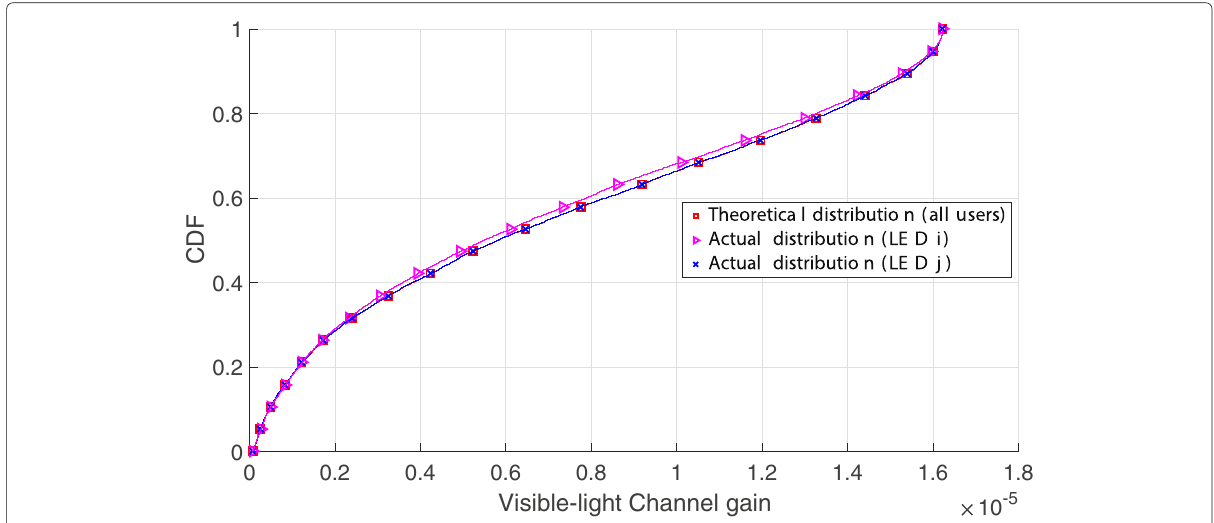
Fig. 8 CDF of multi-cell visible-light channel gains in theoretical and actual